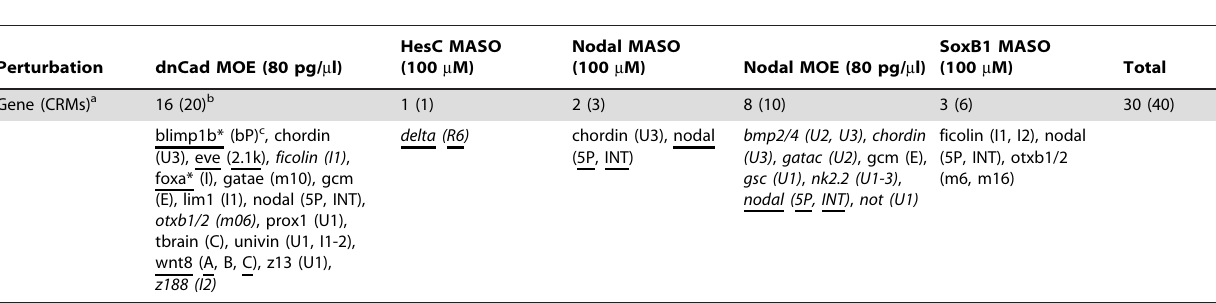
Figure 4. Parallel measurement of CRM responses and gene responses to gene perturbations. The order of genes and CRMs are identical to that shown in Figure 3 . Fold change is shown in log2 scale as indicated in the scale bar. (A) Responses of the 46 genes and the 126 CRMs to five gene perturbations. Genes or CRMs that are up regulated in perturbed embryos at least two folds are red coded and those down regulated at least two folds are blue coded. All experiments were repeated in two different batches of embryos. ‘‘Control 1’’ is a negative control experiment, where two independent sets of control MASO (N-MASO) injected embryos in the same batch are compared, and ‘‘Control 2’’ is a repeat of ‘‘Control 1’’ with a different batch of embryos. N-MASO injected embryos in the control experiments are also used as controls for perturbed embryos. Note that any responses in the controls are false positives, and one set of the N-MASO injected embryos at 12 h (red coded time point) in ‘‘Control 1’’ showed overestimated activities for the majority of CRMs and is considered an outlier. (B) Reproducible responses of the 46 genes and the 126 CRMs to five gene perturbations in two batches of embryos. Only responses that were consistently observed in both experiments in Figure 3 are color coded. All of the false positives except for five in the control experiments were not reproduced, and four reproduced false positives are due to abnormality in one of the N-MASO injected embryos at 12 h. A significant fraction of responses in perturbed embryos were reproduced. doi:10.1371/journal.pone.0035934.g004 Table 1. List of genes and CRMs that showed comparable responses to the